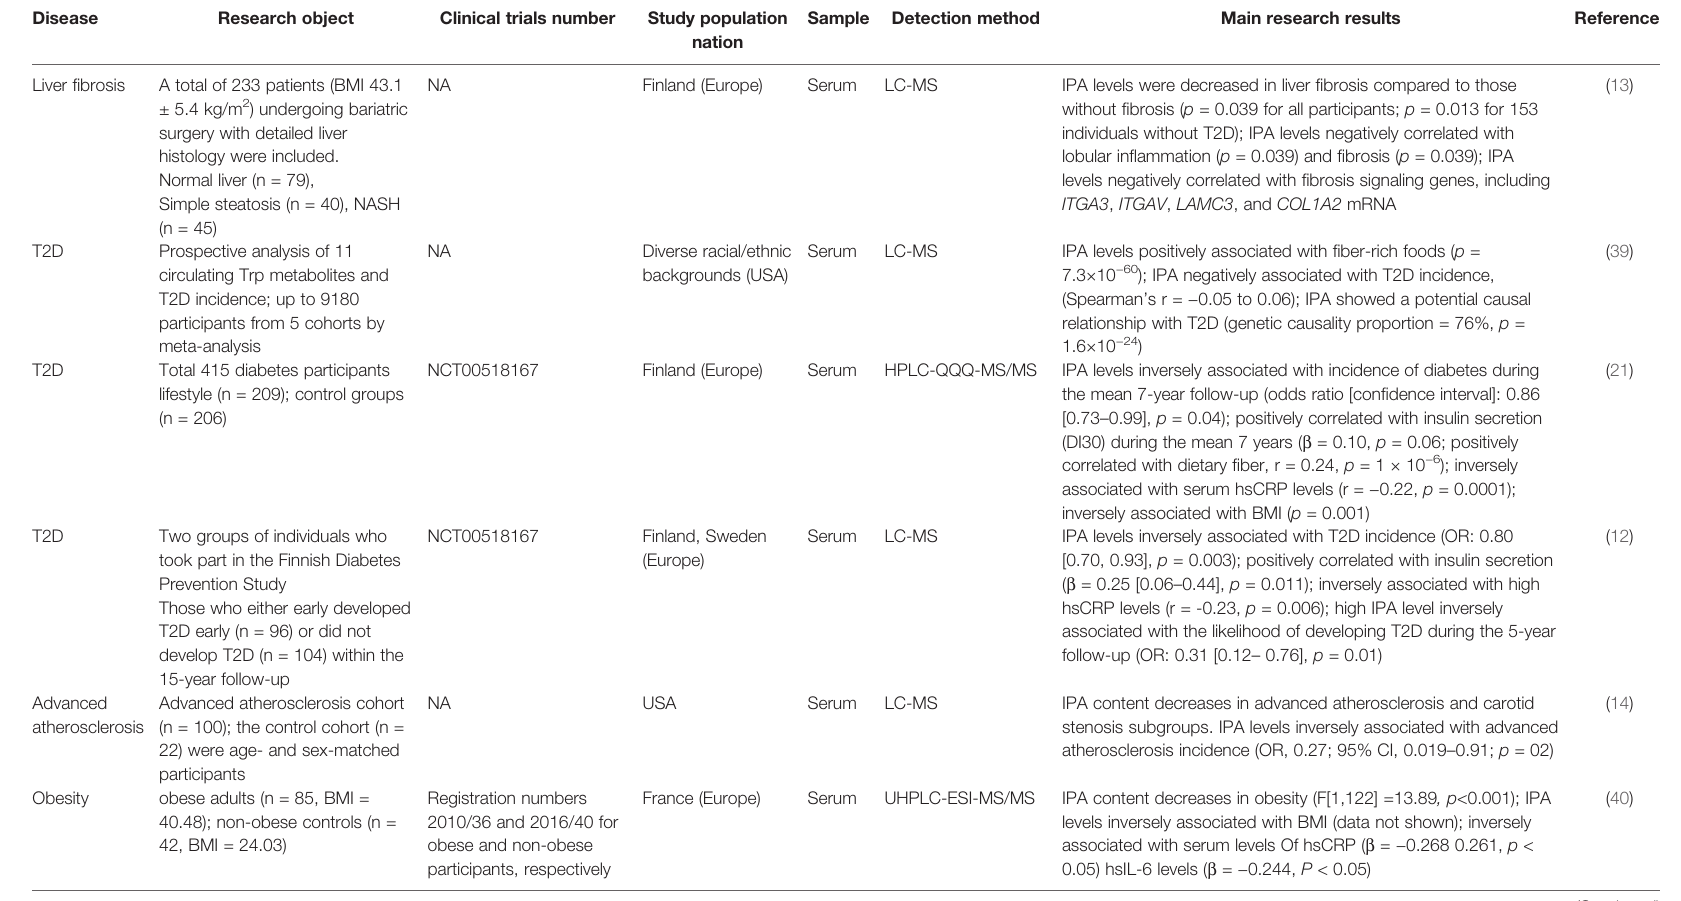
TABLE 1 | The relationship between IPA and metabolic